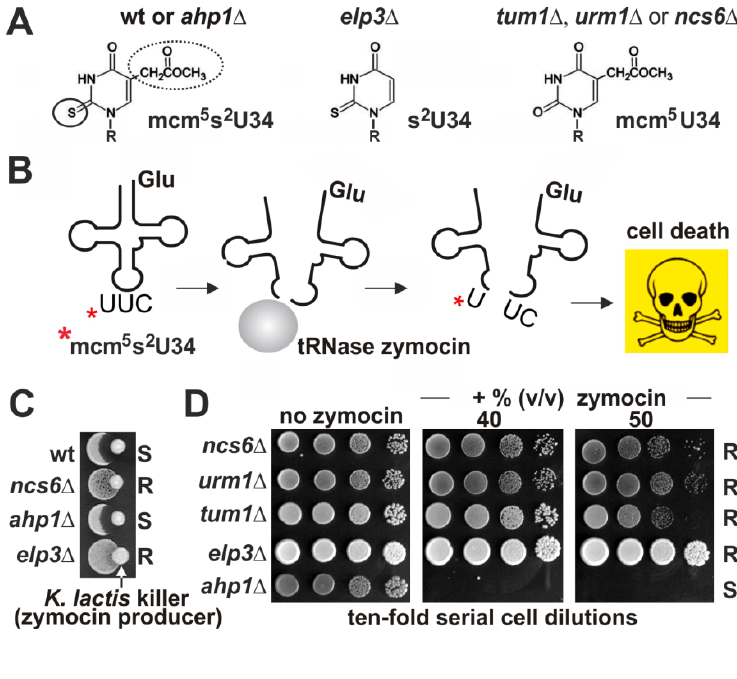
FIGURE 6: The role of Urm1 in tRNA thiolation, not in urmylation of Ahp1, drives tRNase toxici- ty. (A) Shown are wobble uridine (U34) modifica- tions from different genetic backgrounds: 5- methoxycarbonyl-methyl-2-thiouridine (mcm 5 s 2 U- 34), thiouridine (s 2 U34) and 5-methoxycarbonyl- methyl-uridine (mcm 5 U34). For simplicity, ‘R’ denotes ribose moieties. U34 thiolation (solid circle) requires S-transfer via Tum1, Urm1•Uba4 and thiolase Ncs2•Ncs6; mcm 5 side-chain (dotted circle) formation depends on Elongator [24, 28]. (B) The mcm 5 s 2 U34 modification (asterisk) in tRNA Glu U*UC is efficiently cleaved by zymocin, a fungal tRNase lethal to S. cerevisiae cells (see C) [28,56,57]. (C, D) U34 modification defects ( elp3 Δ, tum1 Δ, urm1 Δ, ncs6 Δ) protect against zymocin and loss of Ahp1 urmylation ( ahp1 Δ) confers wild- type (wt) like sensitivity. Growth tests involved killer eclipse assays using K. lactis zymocin pro- ducer and the indicated S. cerevisiae tester strains (see C) or toxin plate assays with ten-fold serial dilutions of the indicated tester strains in absence (left panel) or presence (other panels) of different doses of zymocin purified from K. lactis (see D). ‘S’ and ‘R’ indicate toxin sensitive and resistant re- sponses,